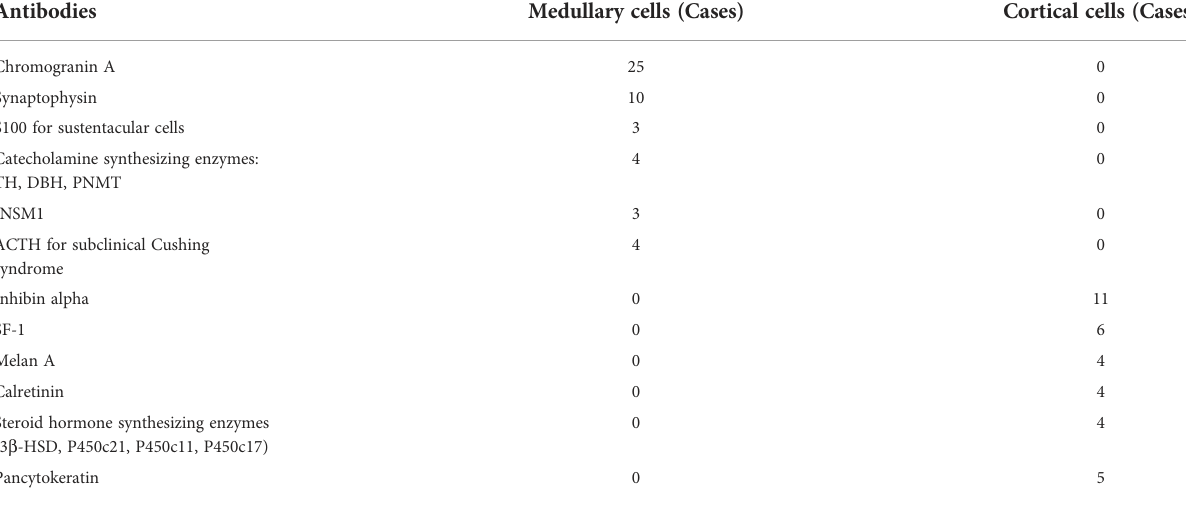
TABLE 1 Immunohistochemical markers used for identifying medullary cells and cortical cells in 28 previous reports of mixed corticomedullary tumors of the adrenal gland.